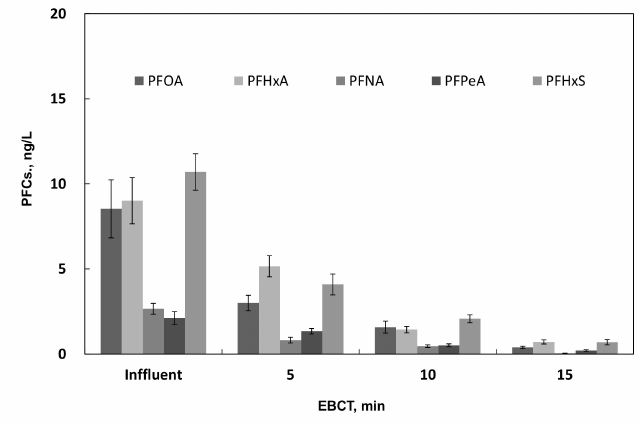
Figure 6. Variations in PFCs concentration by granular activated carbon (GAC)